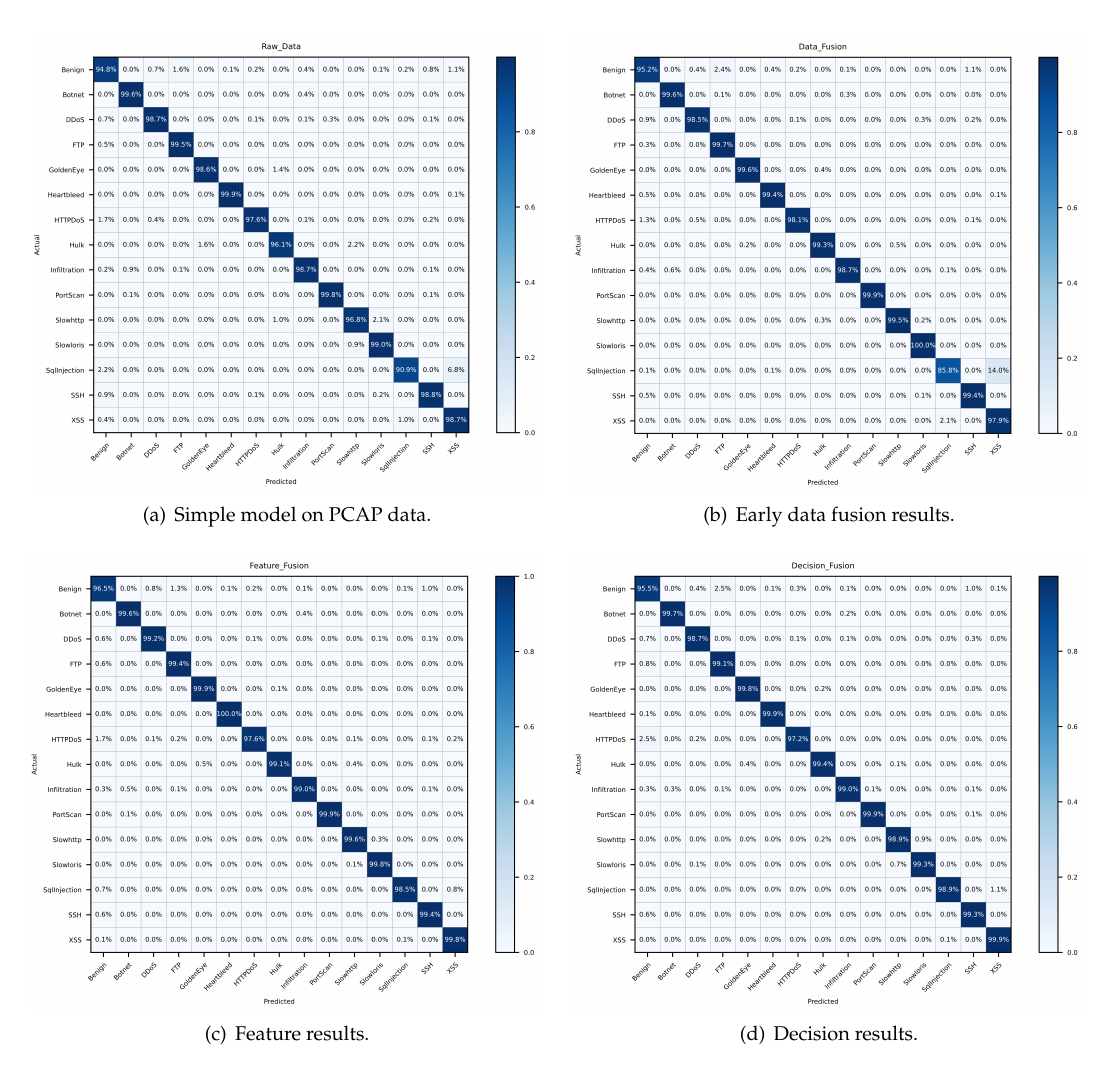
Figure 11. Confusion matrices of detection results on dataset CIC.